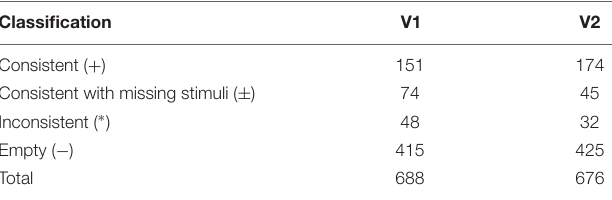
TABLE 4 | Consistency of Atomic Regulons (ARs) with the regulatory network.